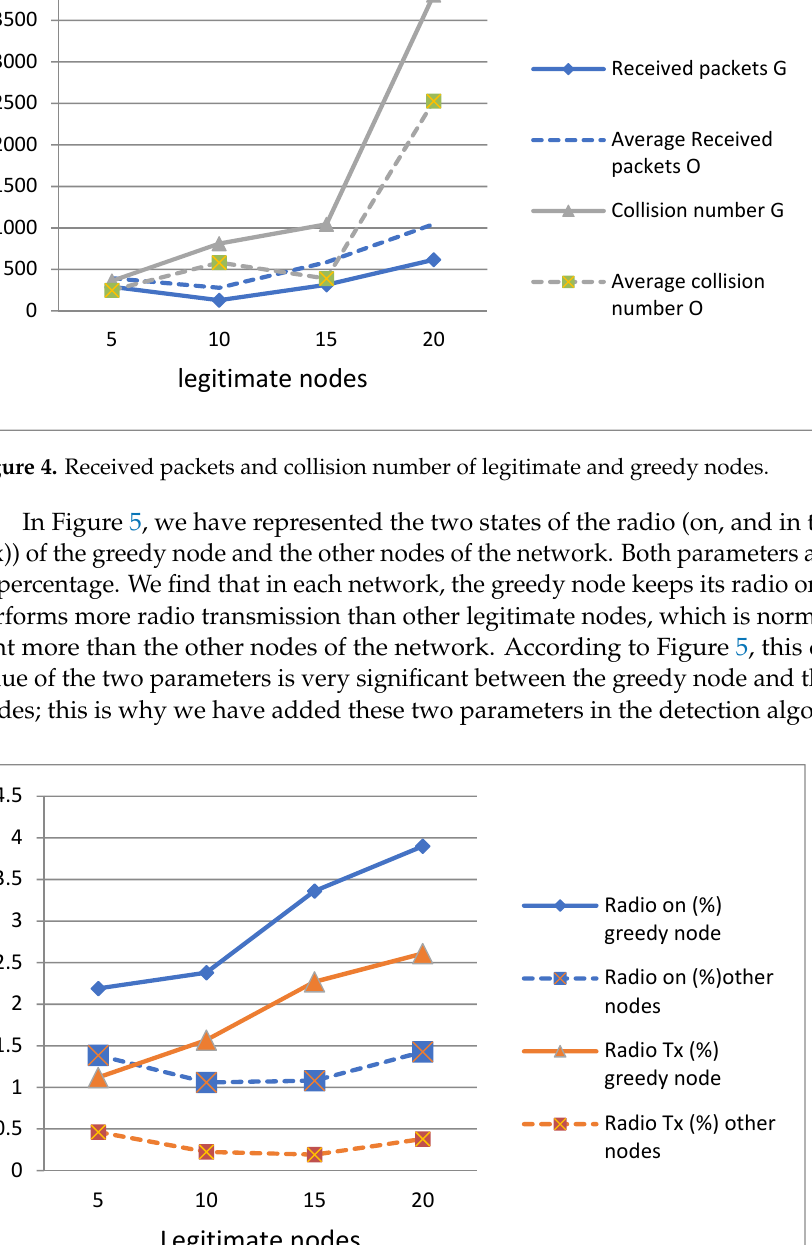
Figure 4. Received packets and collision number of legitimate and greedy nodes.